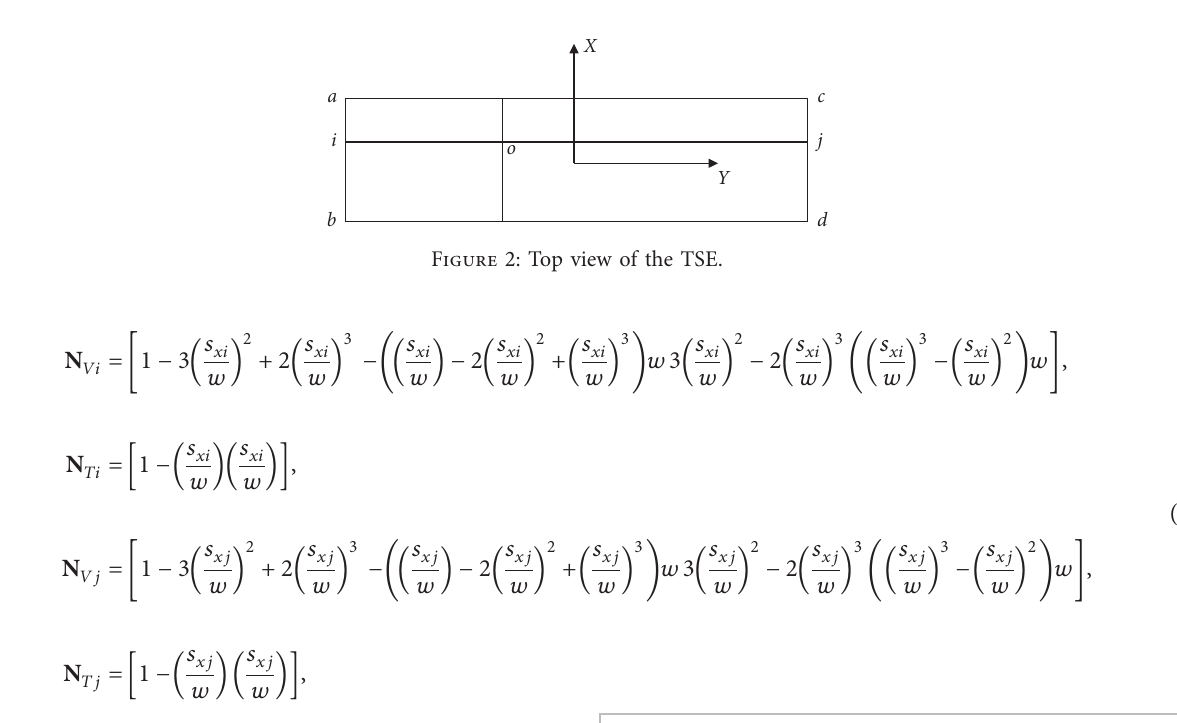
Figure 1: Typical track systems.